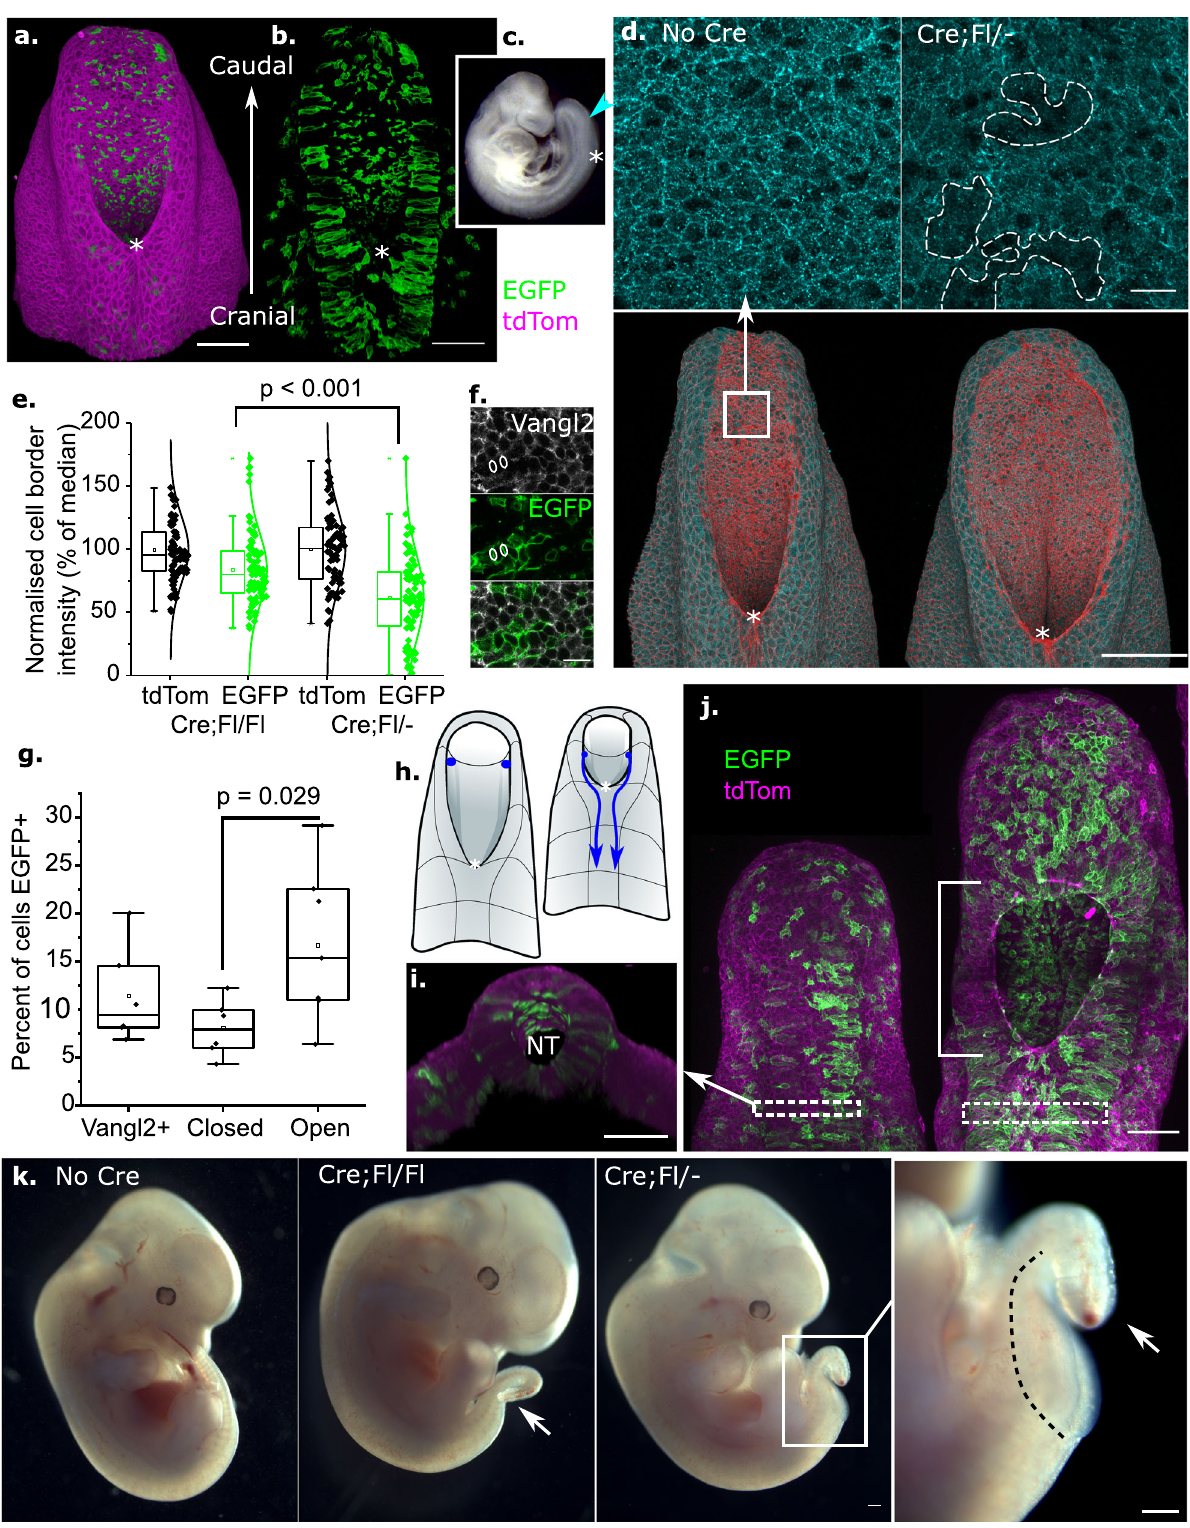
retraction following annular ablation is limited to cell clusters which include Vangl2 -deleted cells. Selective annular ablations which do not include Vangl2 -deleted cells produce equivalent retractions to control embryos (Fig. 3c). This shows apical tension is diminished locally in association with the Vangl2- deleted cells. To test whether the local diminution of neuroepithelial apical retraction around Vangl2 -deleted cells occurs cell autonomously,